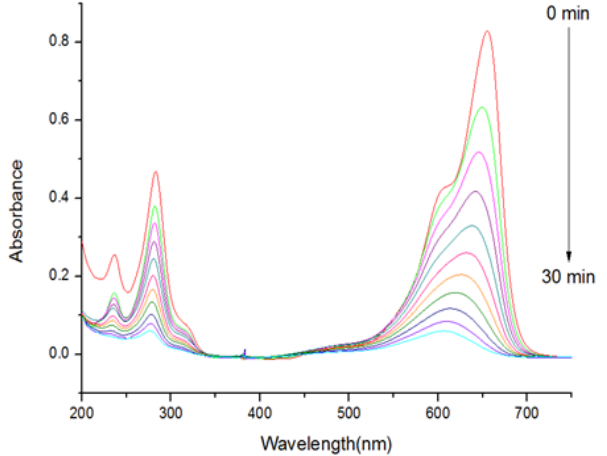
Figure 7. Temporal UV visible absorption spectral changes of methylene blue (MB) in the presence of ZnS:Mn-MAA-pH 7 NC under the UV light irradiation.